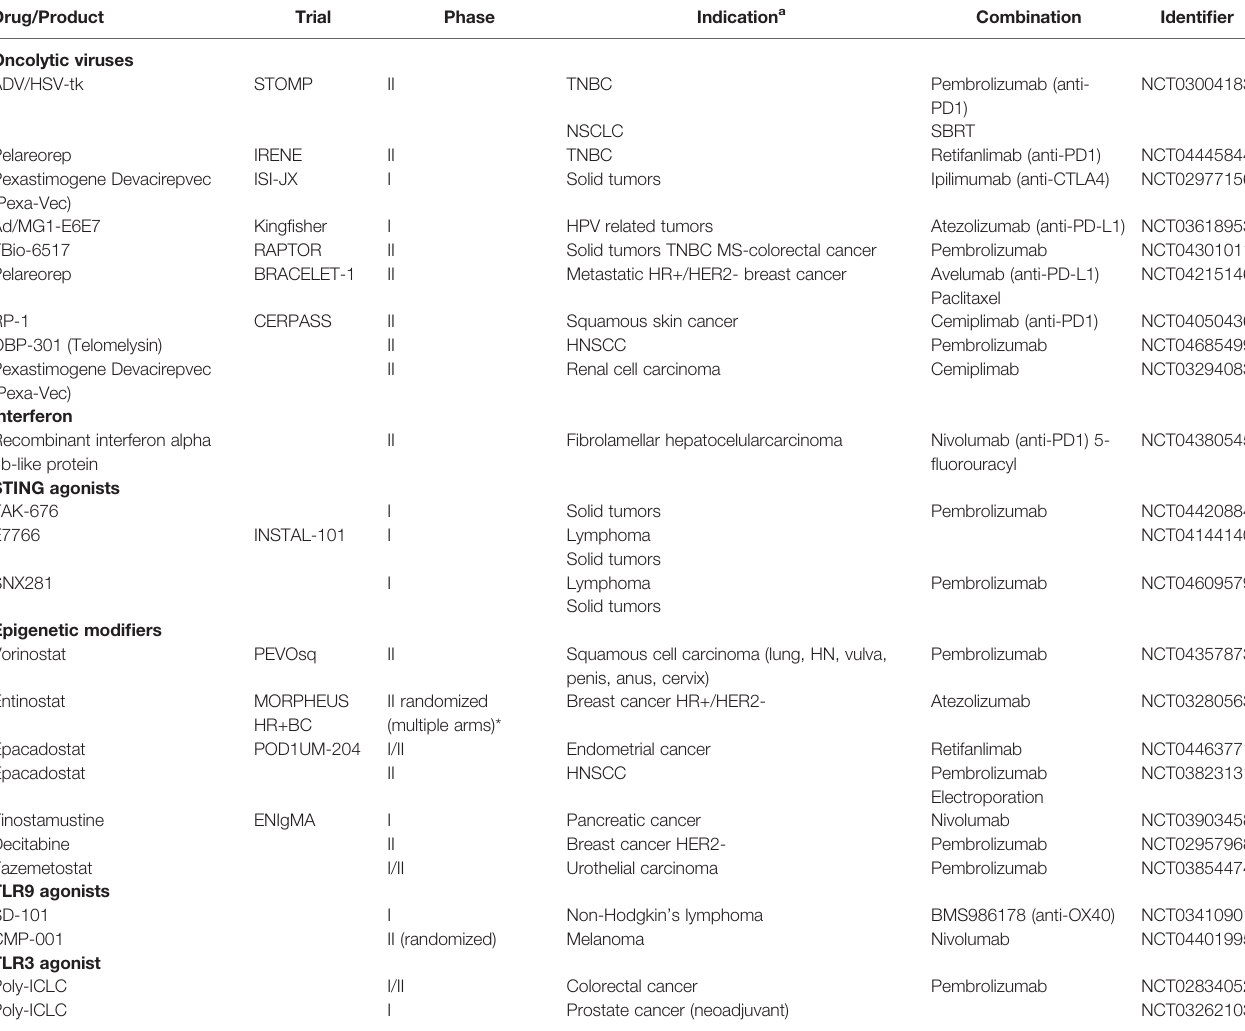
TABLE 2 | Recruiting studies testing immunotherapy in combination with drugs that induce antiviral-like responses.